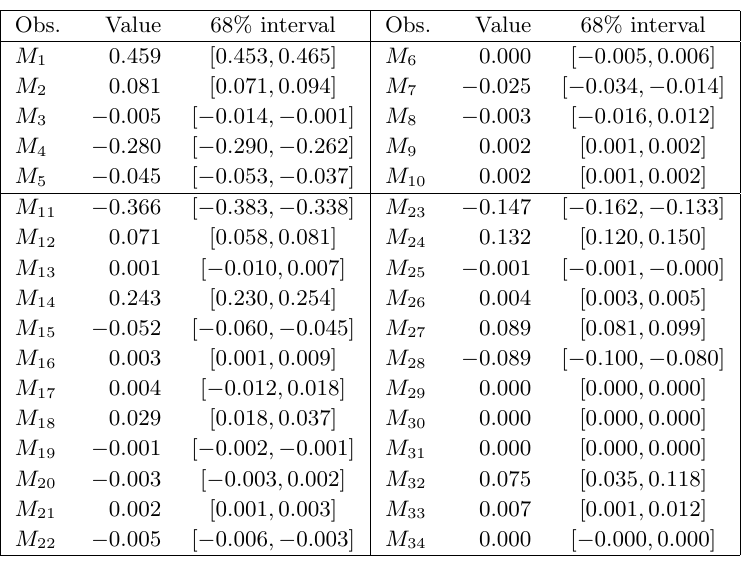
+ (cid:22) (cid:0) decay with P (cid:3) b = 1 b ! (cid:3) (cid:22)